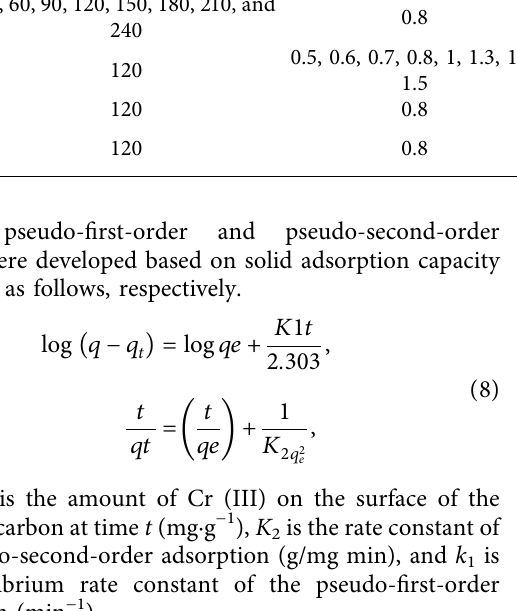
Table 2: Te values of diferent factors of the adsorption experimental conditions. Factor Contact time